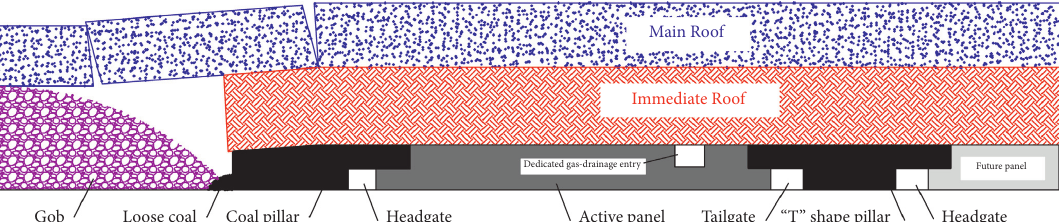
Figure 1: Conventional longwall layout (CLL) with top coal